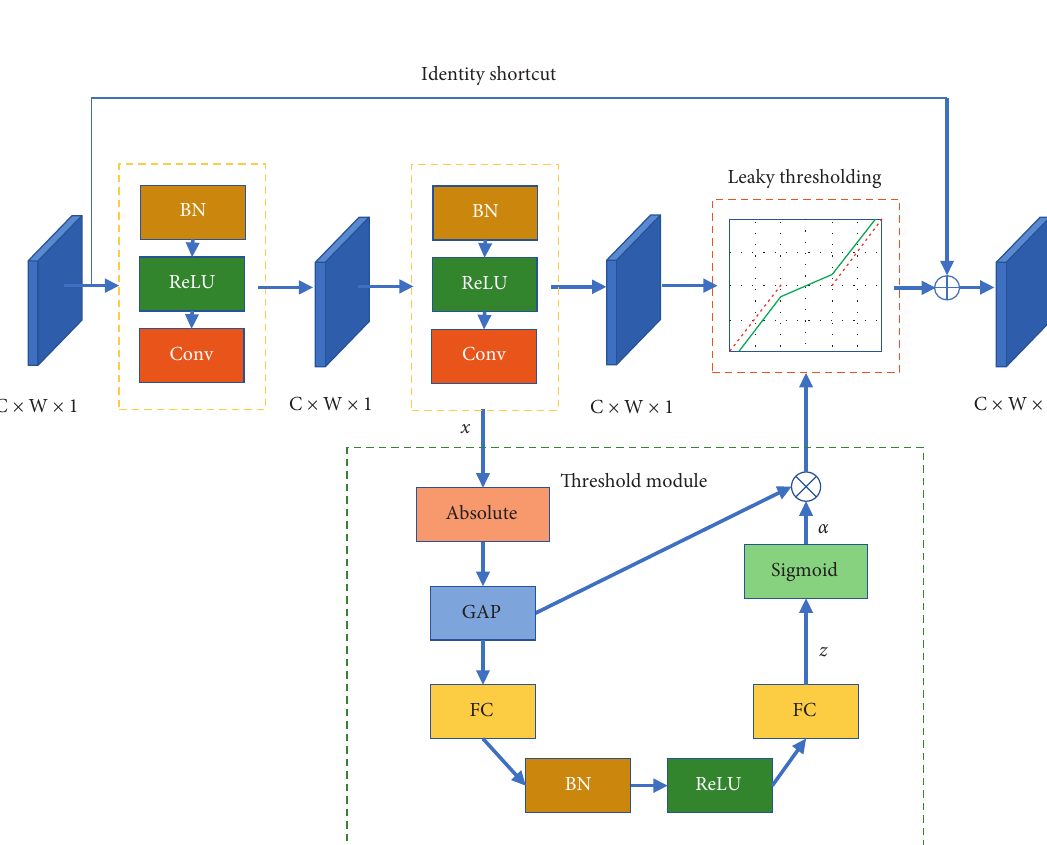
Figure 4: Improved residual shrinkage building unit